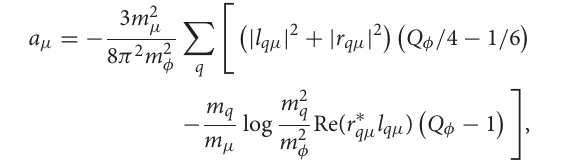
FIGURE 16 | Diagrams contributing to LFV processes, l − α